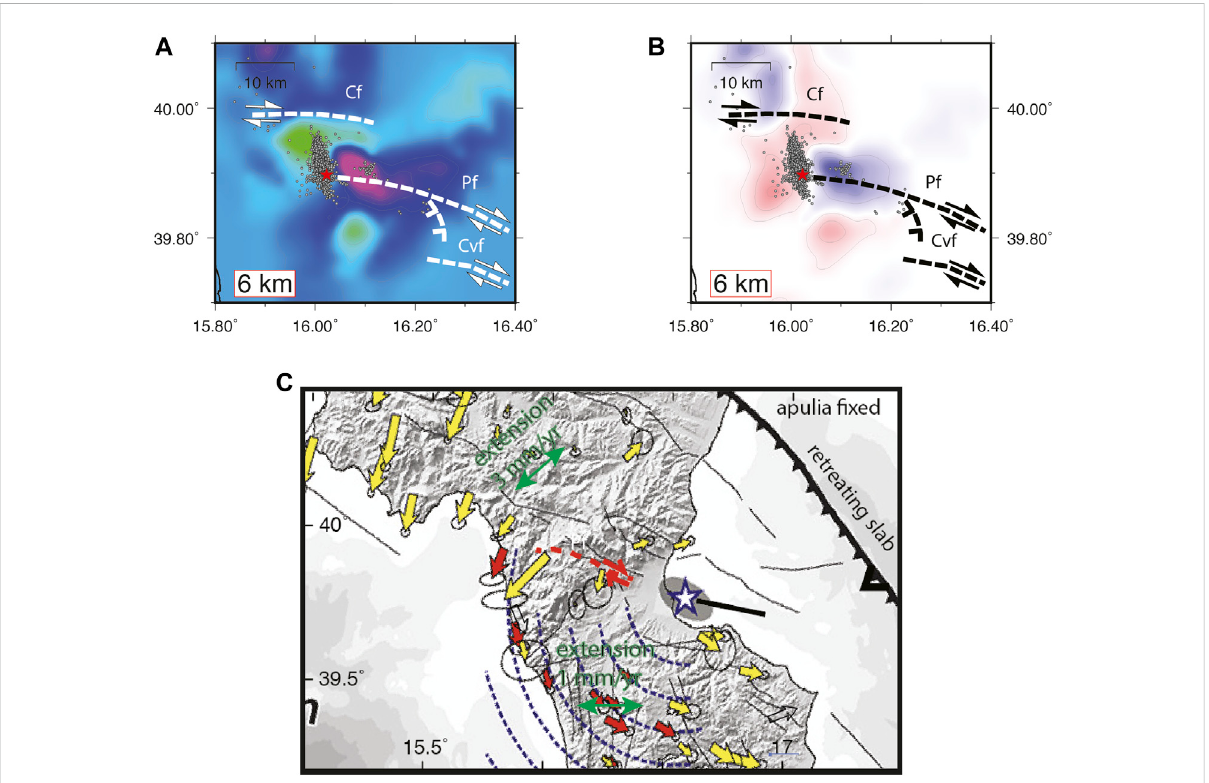
FIGURE 6 (A) Vpand (B) Vp/Vsmodelsat6 kmdepthwiththesystemofwrenchfaultsthatoriginatedthepop-upstructurethathasbeenre-activatedand inverted during the seismic swarm. (C) GPS based velocity fi eld (arrows), together with their 95% con fi dence ellipses. Euler pole is represented as a star (modi fi ed after Palano et al.,